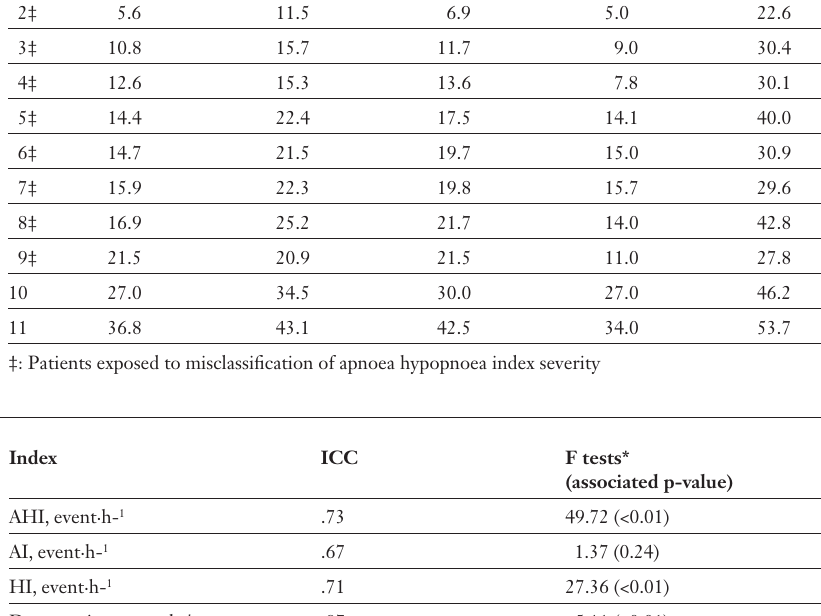
individual apnoea hypopnoea index results.